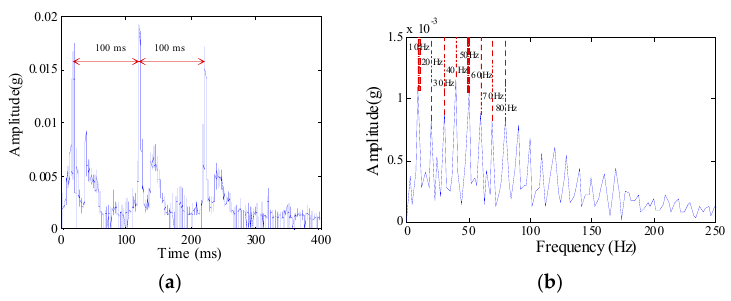
Figure 16. The analytic results of simulation signal’s instantaneous amplitude. ( a ) Time-domain waveform of simulation signal’s instantaneous amplitude; ( b ) The frequency domain waveform of simulation signal’s instantaneous amplitude.